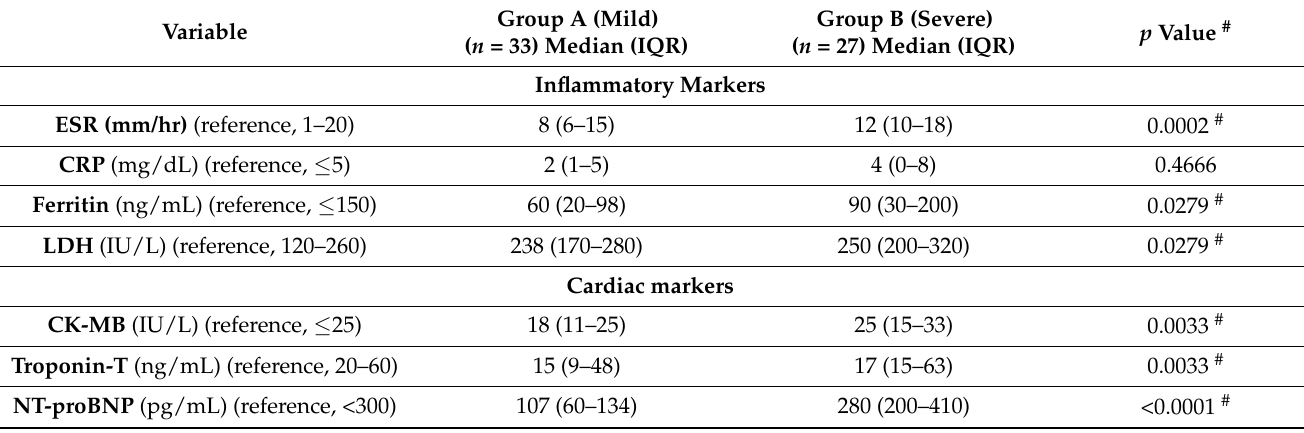
Table 3. Inflammatory markers, cardiac injury markers, and biochemical workup of the study cohort on Day 14 after admission with MIS-C